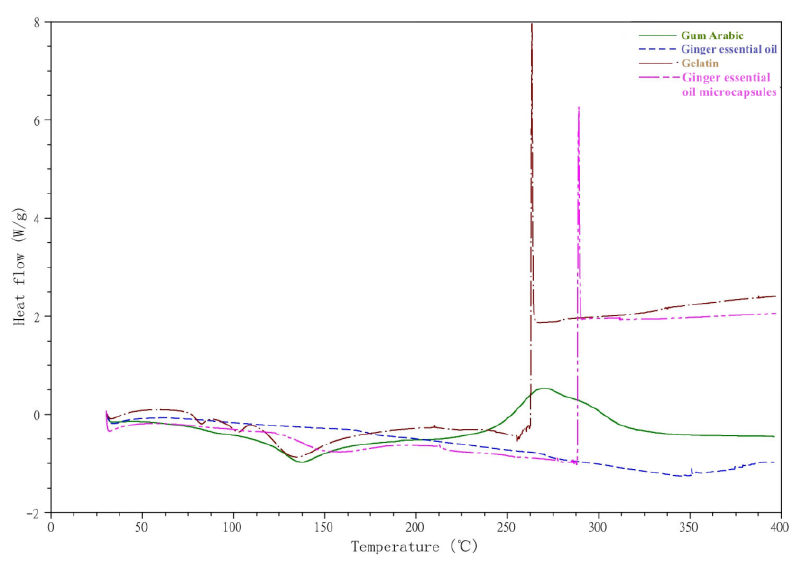
Figure 2. DSC curves of gelatin, gum Arabic, ginger essential oil, and ginger essential oil microcapsules.